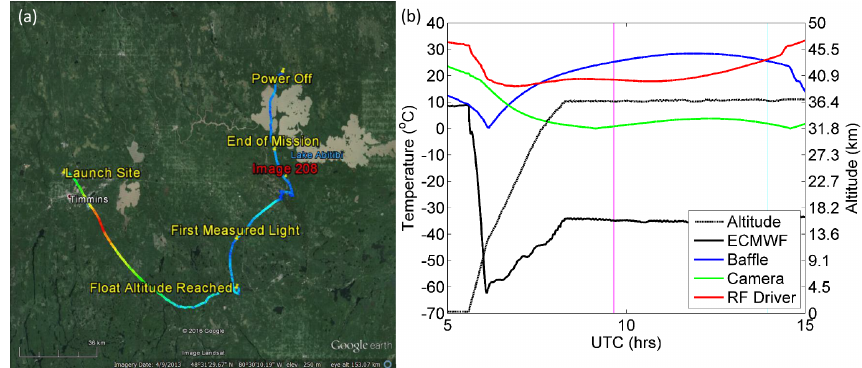
Figure 8. (a) The GPS data from ALI during the Nimbus 7 mission, generated via Google Earth; the colour of the line represents the absolute speed of the gondola during the mission and the blue, green, and red colours represent speeds of approximately 10, 70, and 140 kmh − 1 . Important landmarks are noted on the image. The end of mission represent the end of the aerosol mission. No GPS data were collected from ALI after power down. The location of image 208 is the red label. (b) The temperature and altitude profiles from the NIMBUS 7 flight; the time of image 208 is shown by the cyan vertical line and first light measured by ALI is represented by the magenta vertical